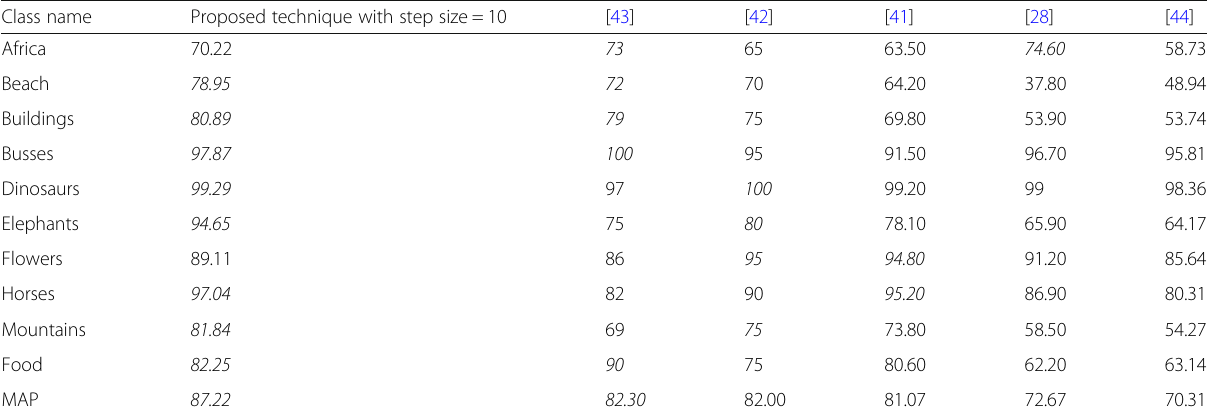
Table 2 MAP performance comparison of the proposed technique with recent CBIR techniques on the image benchmark of the Corel-1 K